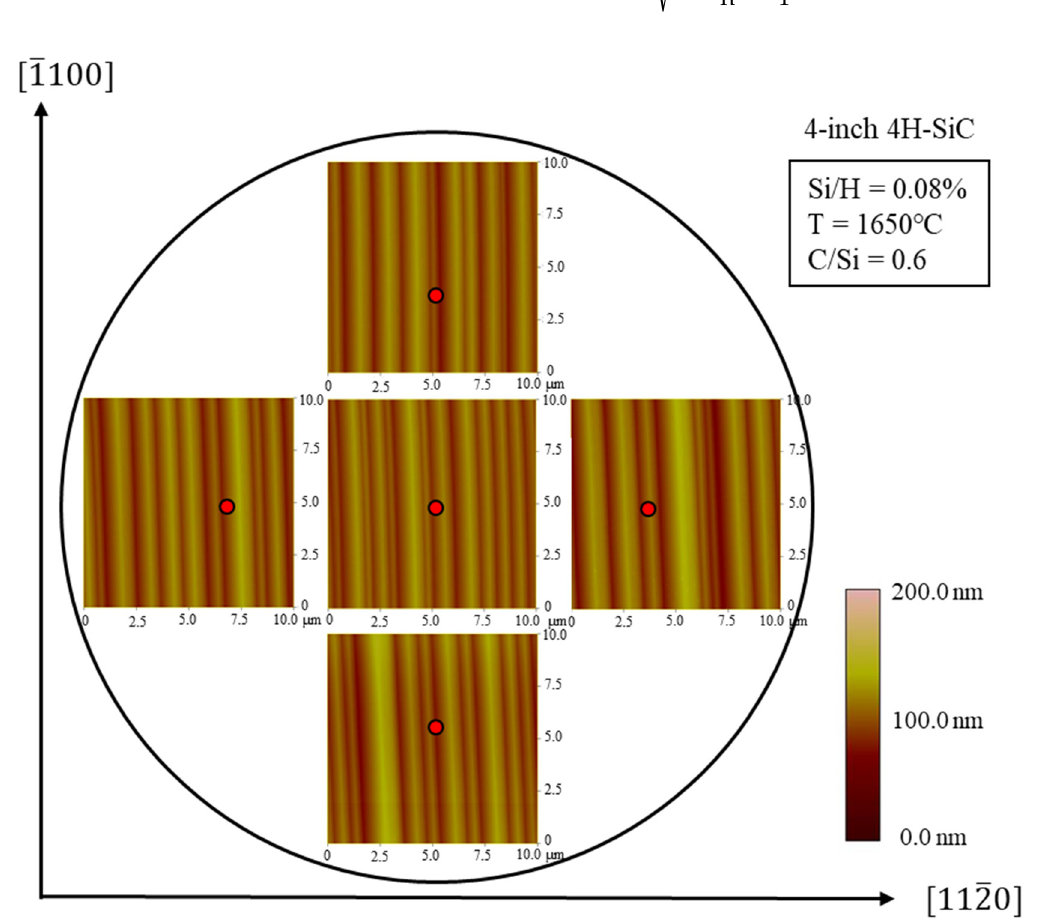
Figure 3. Schematic diagram of RMS measurements of 4H-SiC wafers.